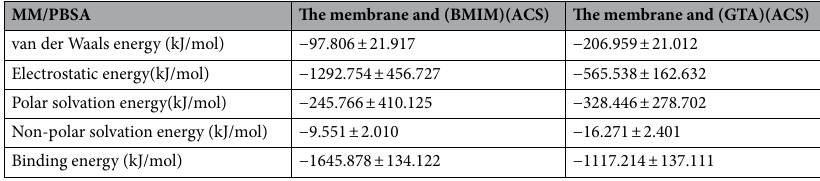
Table 5. Various energy terms obtained through MM/PBSA calculations.